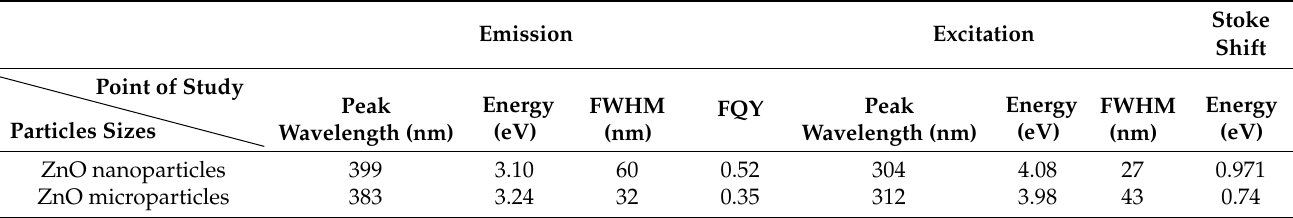
Table 2. Summary of ZnO NPs fluorescence of EPD solution samples. Fluorescence spectrometer of ZnO particles immersed in DI water under fixed wavelength ( λ = 315